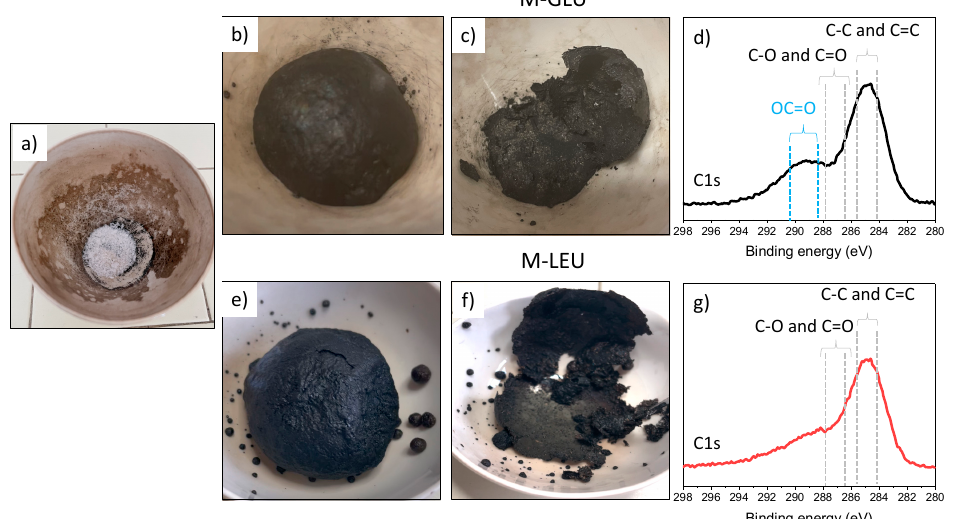
Figure 2. Intumescent behavior of M-GLU and M-LEU: ( a ) typical PAA powder sample before heat treatment; ( b , e ) expanded chars immediately after heating to 350 °C; ( c , f ) cut surfaces of the char samples; ( d , g ) XPS spectra of chars.